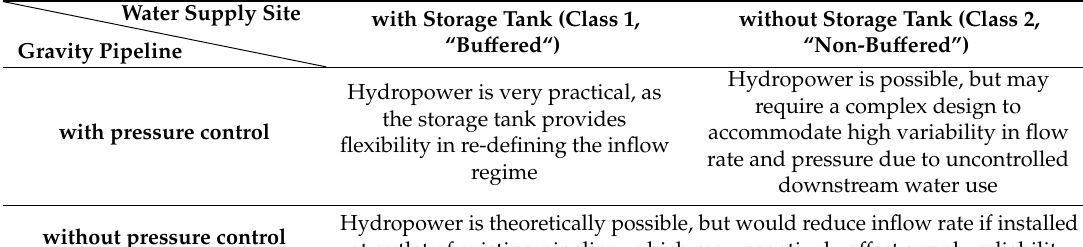
Table 1. Matrix of consequences for drinking water hydropower development, depending on the type of gravity pipeline and